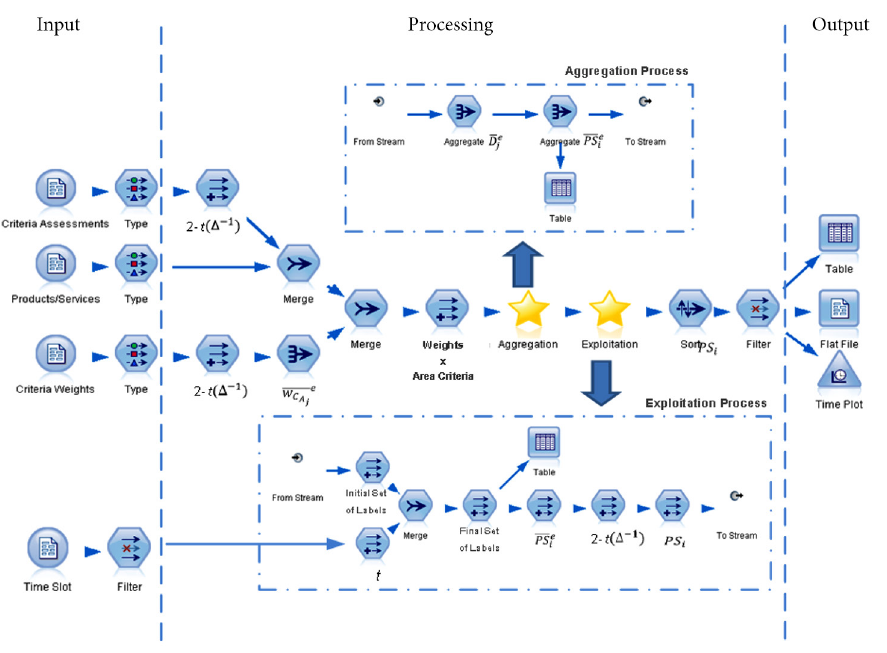
Figure 3. Implementation of the LMCDM model proposed using IBM SPSS